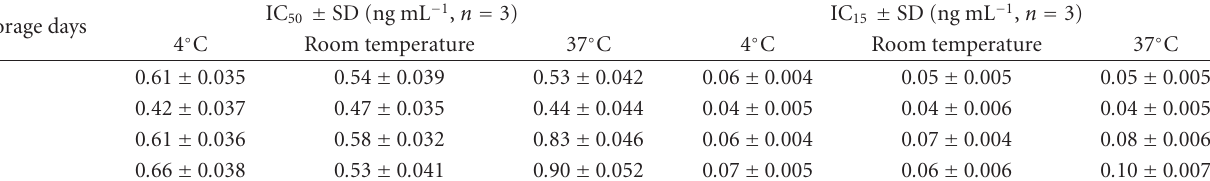
Table 2: Stability of the enzyme tracer.